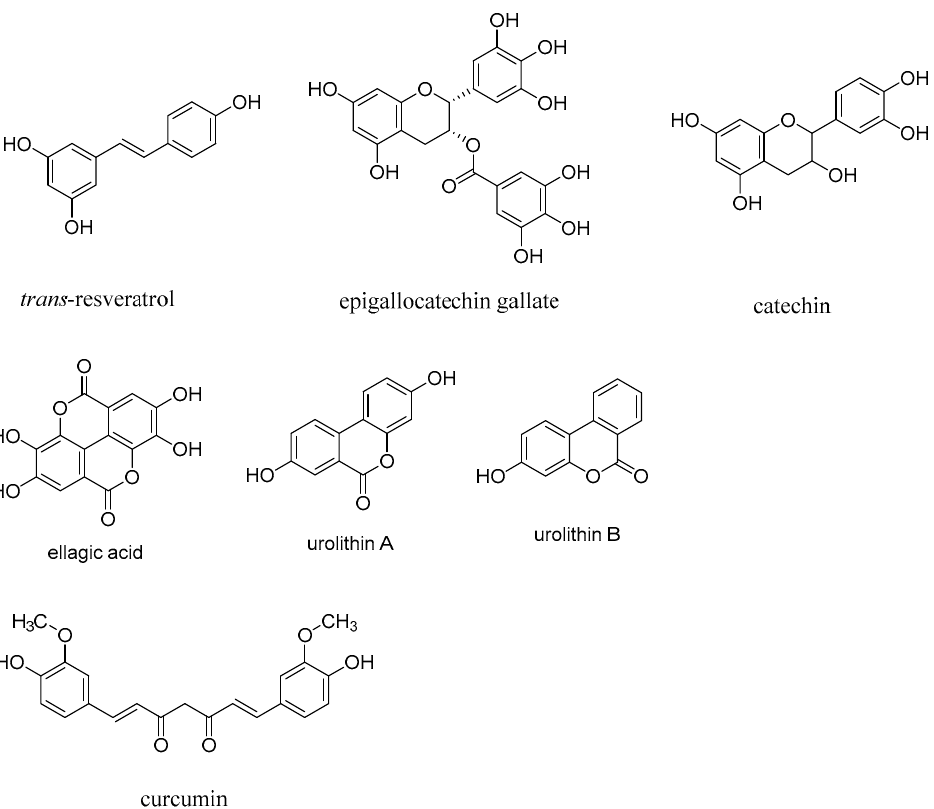
Figure 10. Structures of polyphenolic antioxidants, trans -resveratrol, curcumin, catechin, epigallocatechin gallate, ellagic acid, urolithin A, and urolithin B.